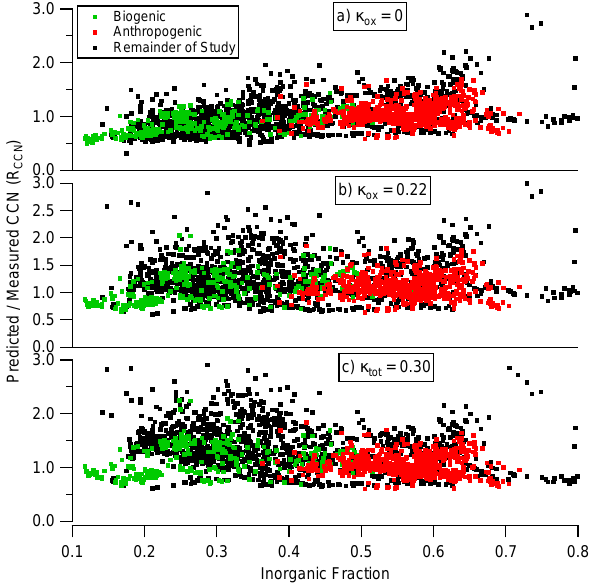
Fig. 1. Ratio of predicted to measured CCN concentrations plotted against aerosol inorganic fraction. Panel (a) shows the case in which all of the organic component is assumed to be non-hygroscopic ( κ org =0) while (b) shows the case in which κ ox =0.22. Panel (c) assumes a constant κ of 0.30 for the entire aerosol. Red and green points refer to data from the Anthropogenic and Biogenic periods, respectively (see Fig. 3), while the remainder of the study is repre- sented by black